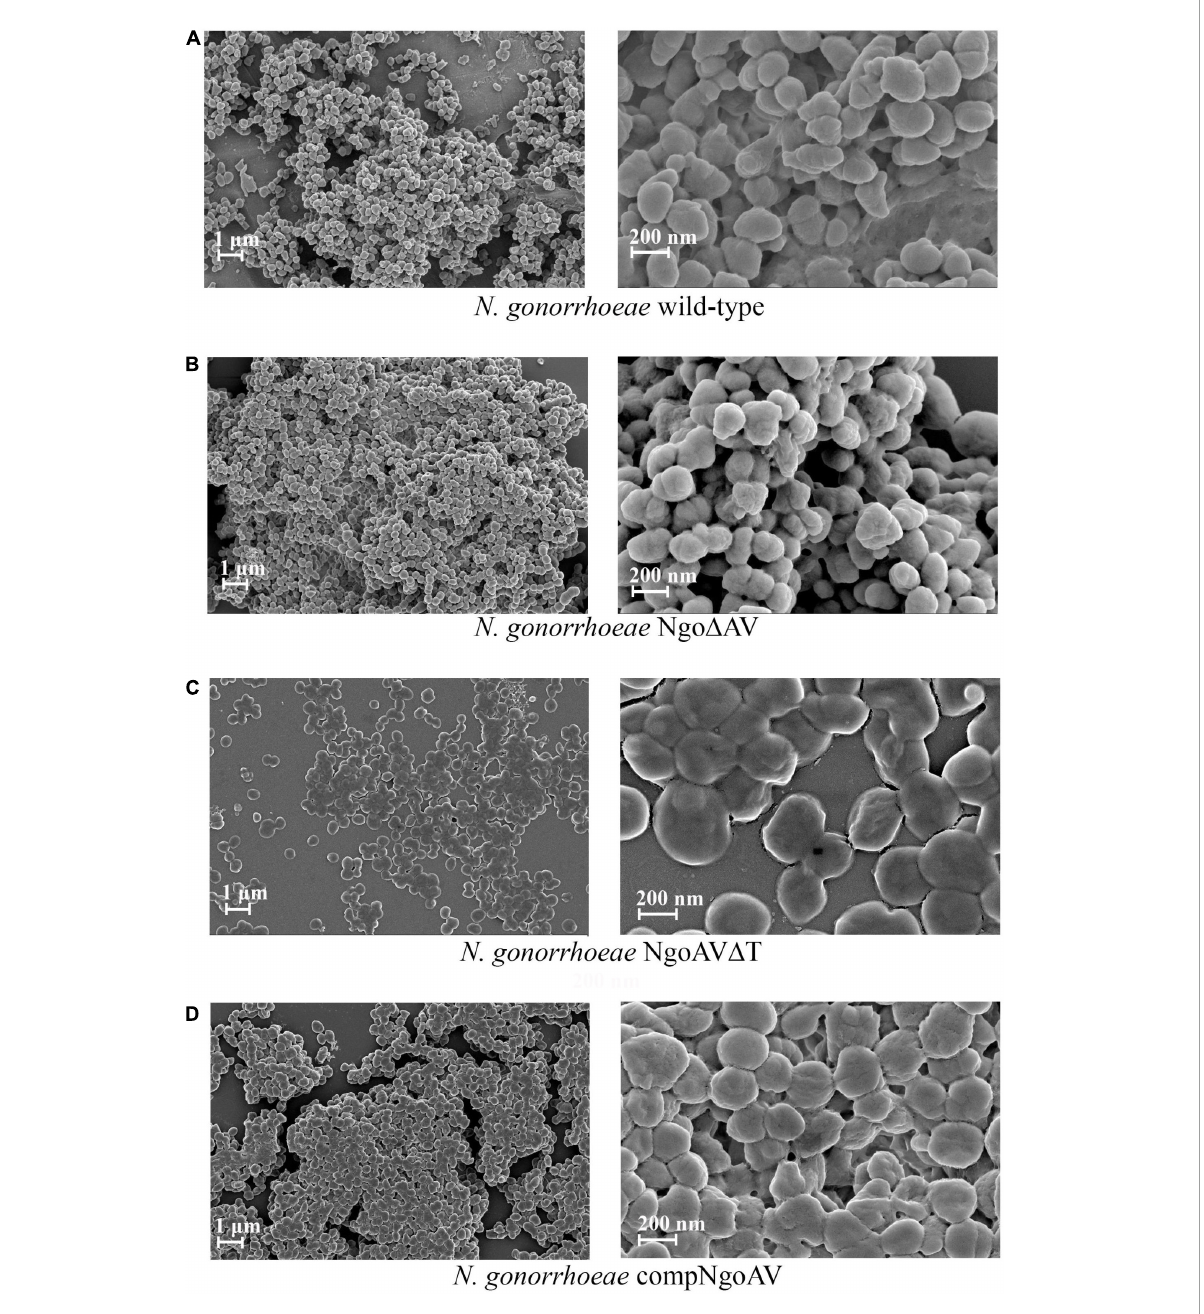
FIGURE4 Biofilms produced by N. gonorrhoeae variants within M.NgoAV locus after 24 h of growth, visualized by Field Emission Scanning Electron Microscopy. (A) Biofilm formed by the wt FA1090 strain; (B) Biofilm formed by the N. gonorrhoeae Ngo (cid:49) AV; (C) Biofilm formed by the N. gonorrhoeae NgoAV (cid:49) T mutant; (D) Biofilm formed by the N. gonorrhoeae compNgoAV strain. Experiments were triplicated and representative photographs are